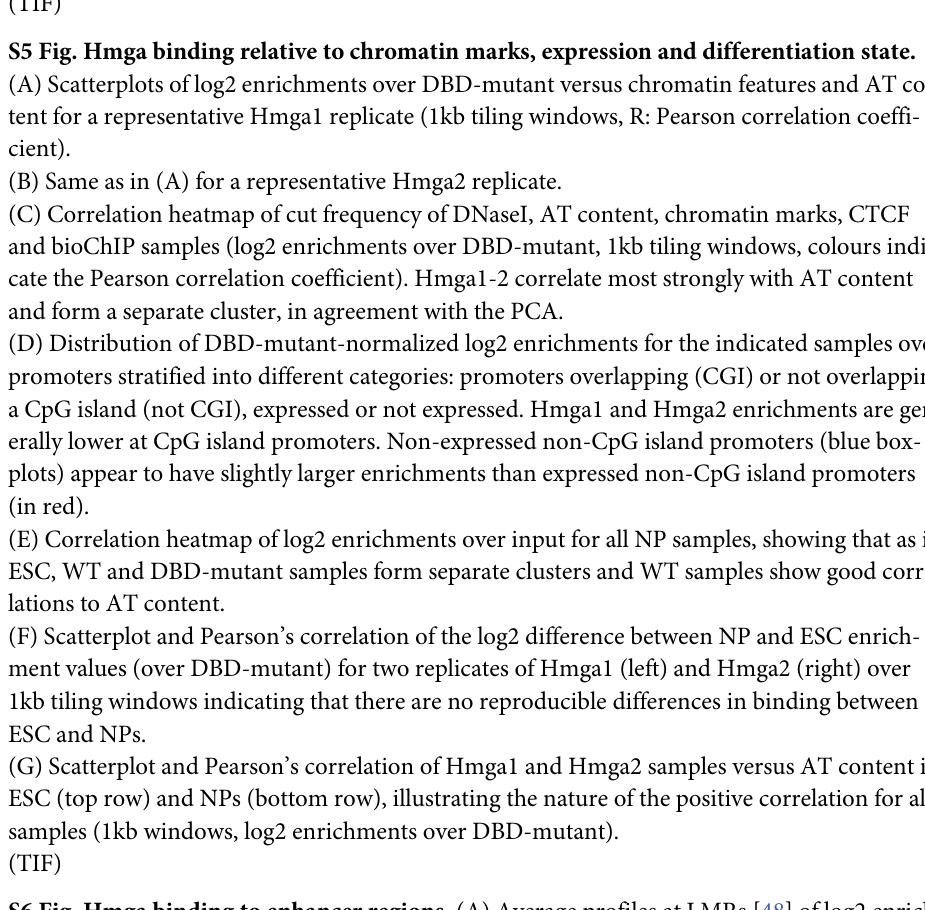
ments over DBD-mutant for two replicates of Hmga1 (top row) and Hmga2 (bottom row) in